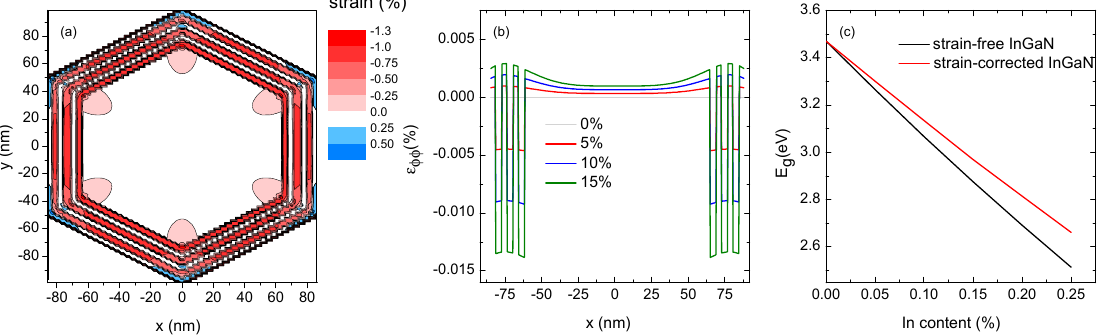
Figure 7. ( a ) Cross-sectional map of the angular strain component ( ε ) for InGaN MQWs with 10% In concentration. ( b ) Evolution of the angular strain component along the x -direction ( y = 0) for different In concentrations. ( c ) Band gap energy of strain-free and strained InGaN for different In concentrations.